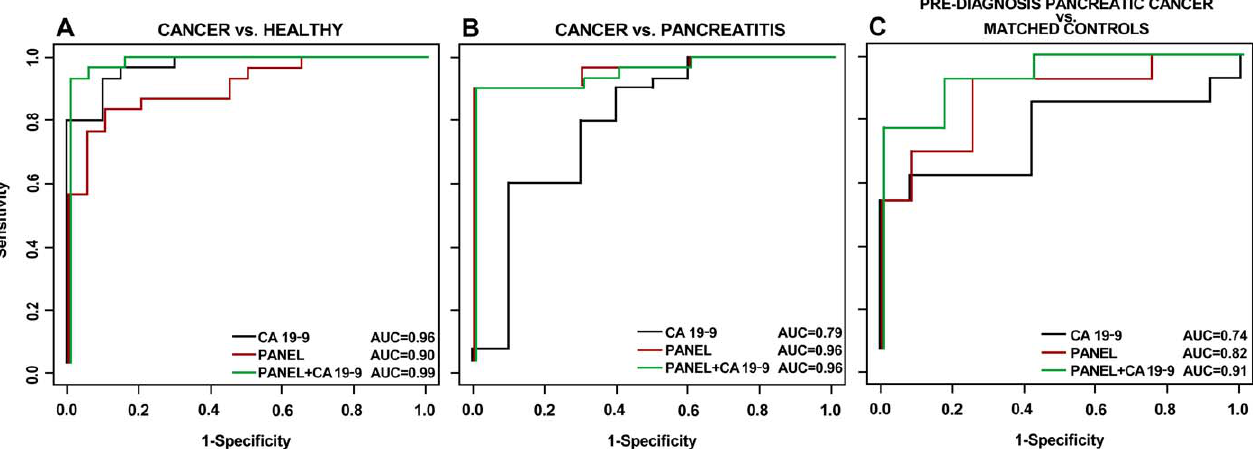
Figure 6. ROC in Assays of Human Samples for Two Panels of Proteins Identified in Proteomic Analysis of Plasmas from Tumor-Bearing Mice ROC curves based on ELISA measurements of ALCAM, ICAM1, LCN2, TIMP1, REG1A, REG3, and IGFBP4 as a panel with or without CA19–9 comparing pancreatic cancer versus healthy controls (A) and pancreatic cancer versus pancreatitis (B). This panel of candidates was chosen on the basis of up- regulation in tumor-bearing mice. As expected, CA19–9 performed well in comparisons with healthy individuals as controls; however, the chosen panel was significantly better than CA19–9 alone when pancreatitis patients were used as controls. (C) The panel tested with prediagnostic sera (LCN2, TIMP1, REG1A, REG3, and IGFBP4) was chosen on the basis of up-regulation at the PanIN stage. This panel performed slightly better in comparison to CA19–9 but a combination of CA19–9 with the panel of candidates significantly improved discrimination between early stage (prediagnostic) sera and matched controls. Standardization procedures and composite marker ROCs were generated without fitting, by inclusion of all tested candidate markers. Specimens from controls and pancreatitis patients were obtained from the same institution and with the same protocol for blood collection. For details see Materials and Methods and Tables S1 and S2.